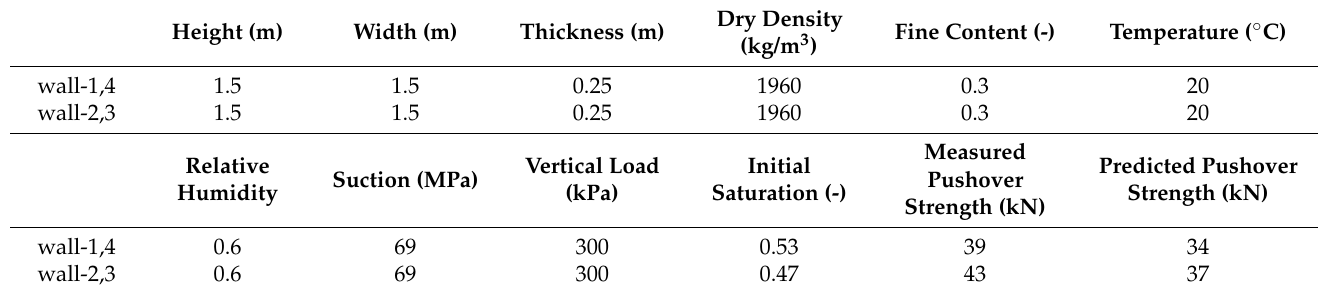
Table 5. Comparison of the measured and predicted pushover strengths of URE walls.